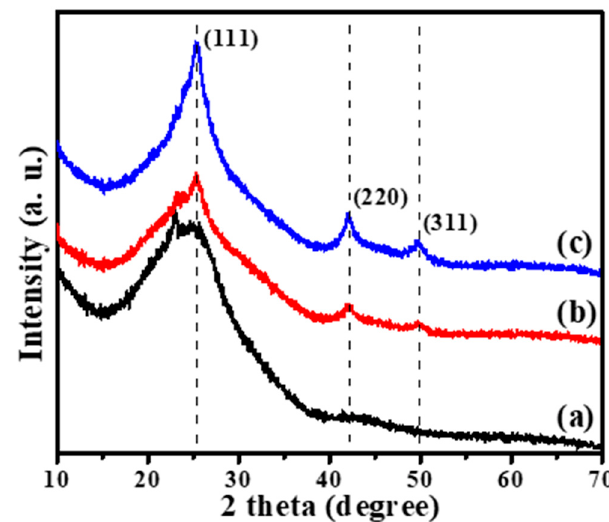
Figure 1. XRD diffraction patterns: ( a ) Electrospun carbon nanofibers (ECNFs), ( b ) Cadmium selenide/electrospun carbon nanofibers (CdSe@ECNFs), and ( c ) Co-doped CdSe@ECNFs (Co-CdSe@ECNFs).